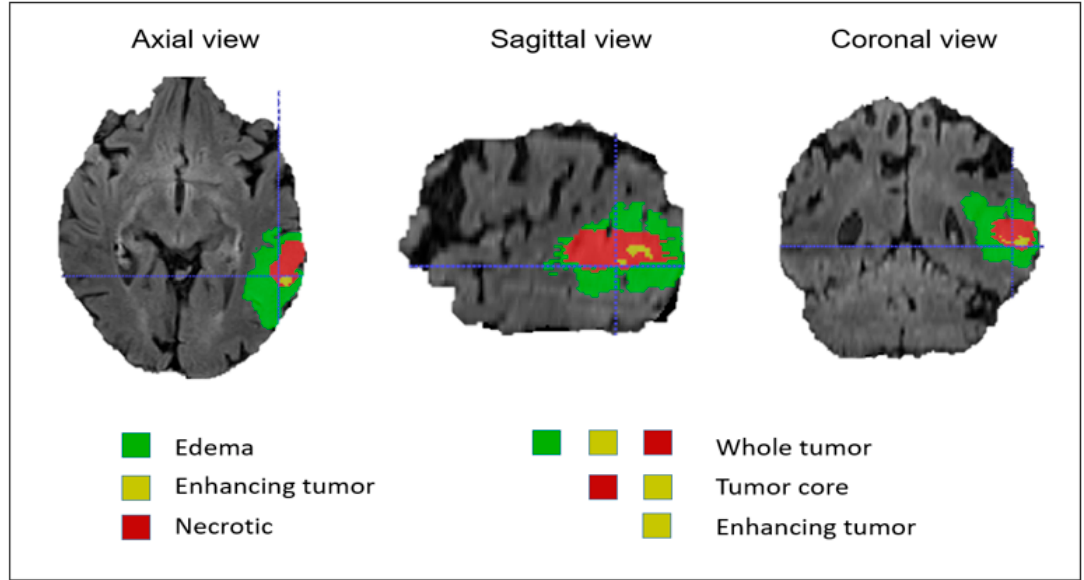
Figure 3. Brain tumor mask based on intratumoral structures and tumor subregions.